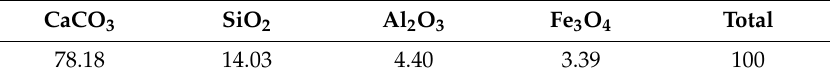
Figure 2. The distribution of dolomite crystals inside YMS1 and CG1 rocks: ( a ) dispersive distribution, ( b) mosaic distribution. Table 2. Raw material composition of cement clinker without alkali (wt %). Table 2. Raw material composition of cement clinker without alkali (wt %).